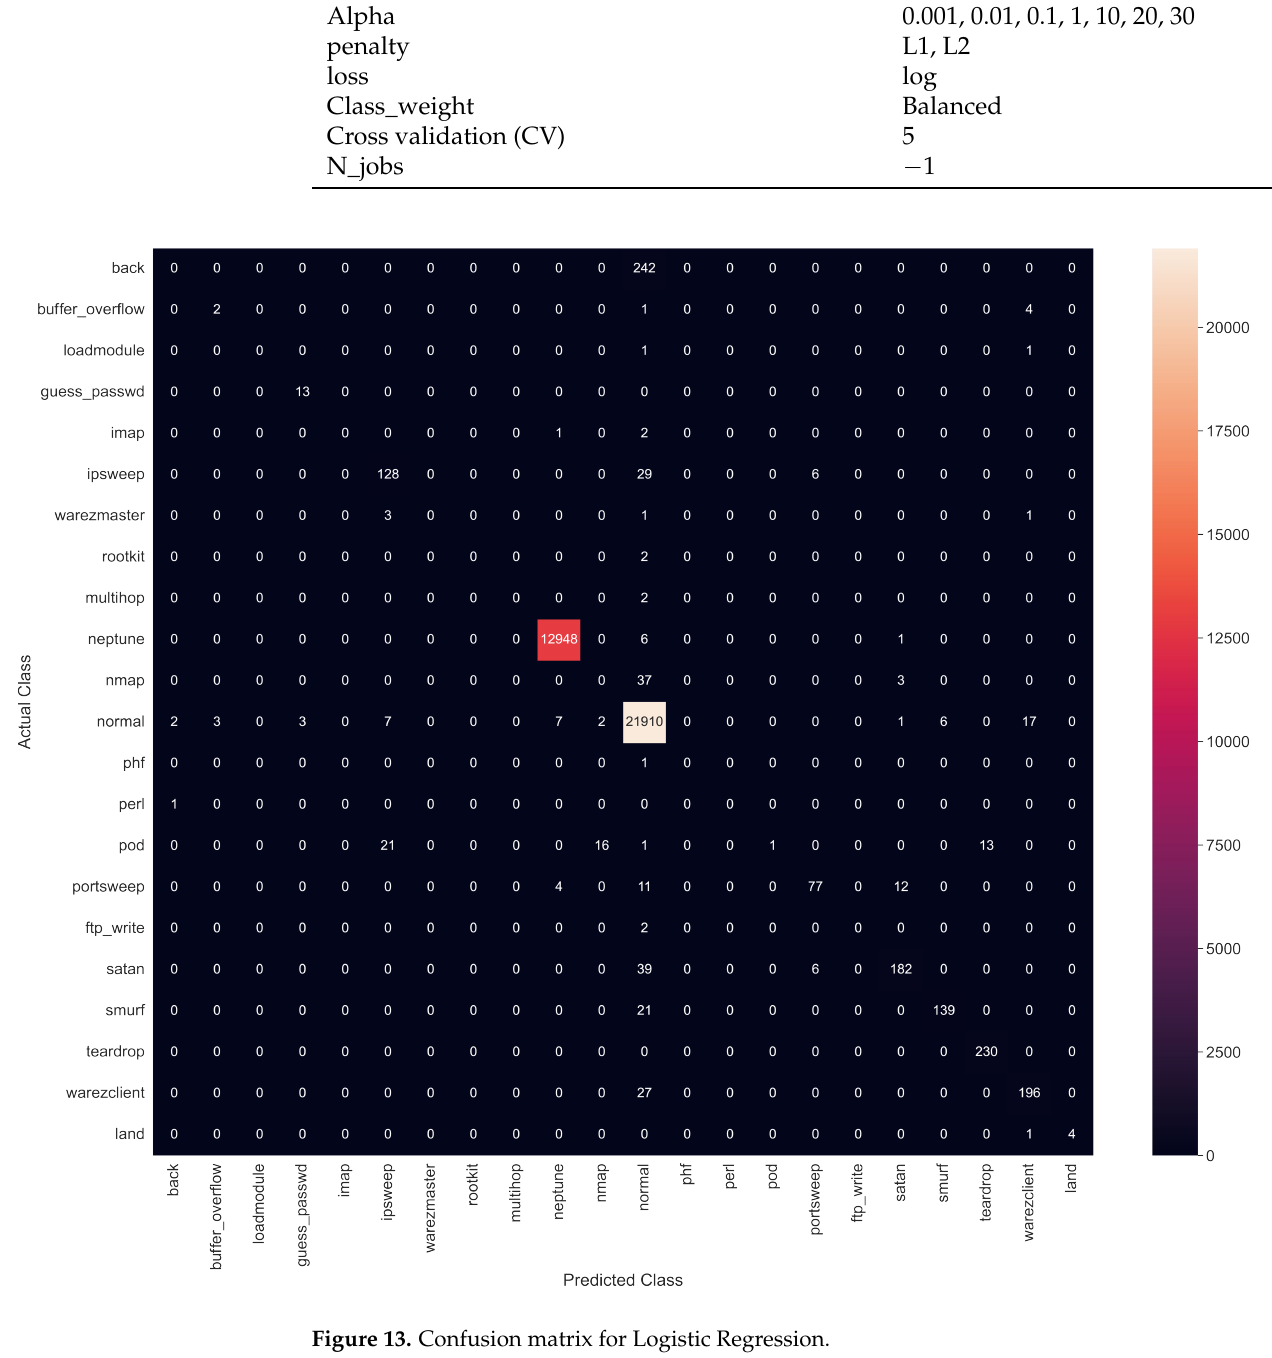
Figure 13. Confusion matrix for Logistic